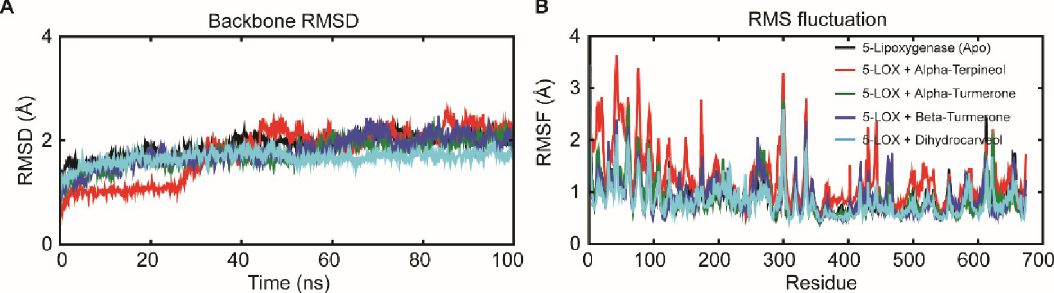
Fig 4. Intrinsic dynamics stability and flexibilities of the 5-LOX complex systems during all-atoms MD simulation of 100 ns. (A) Backbone RMSD of the five systems (including apo form and holo form of 5-LOX) membrane-water system during 500-ns MD simulations. ( B ) The C α -root mean squared fluctuation (RMSF) profile of each amino acid of 5-LOX apo and holo systems during simulation in the lipid bilayer